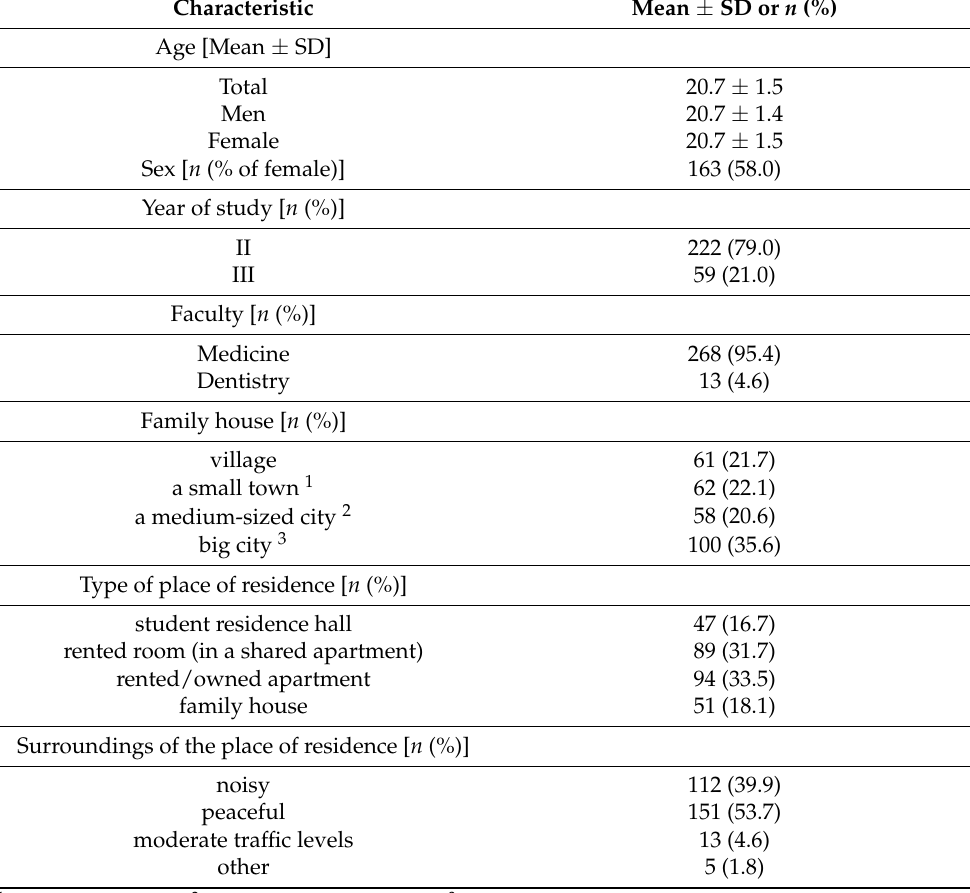
Table 1. Characteristics of the studied population/ n (%), Mean ± SD/; n = 281.